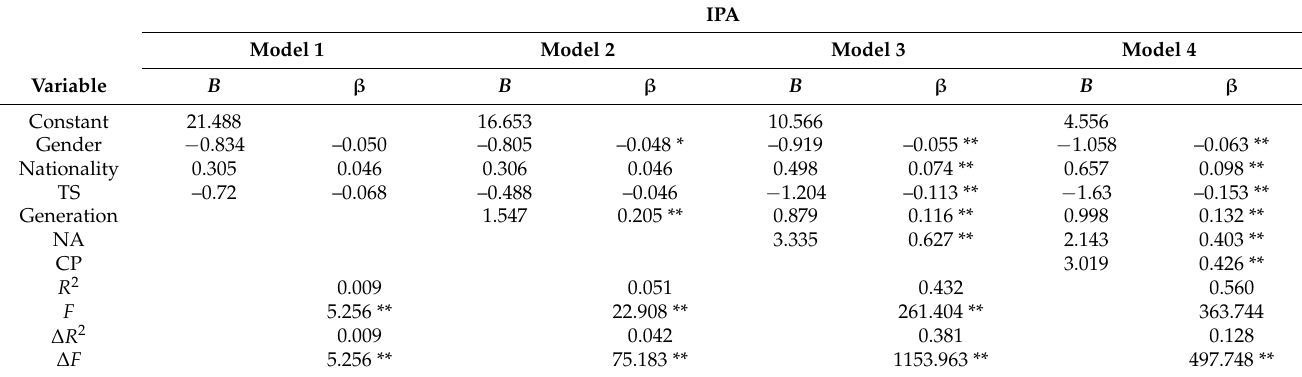
Table 7. Hierarchical multiple regression analysis for